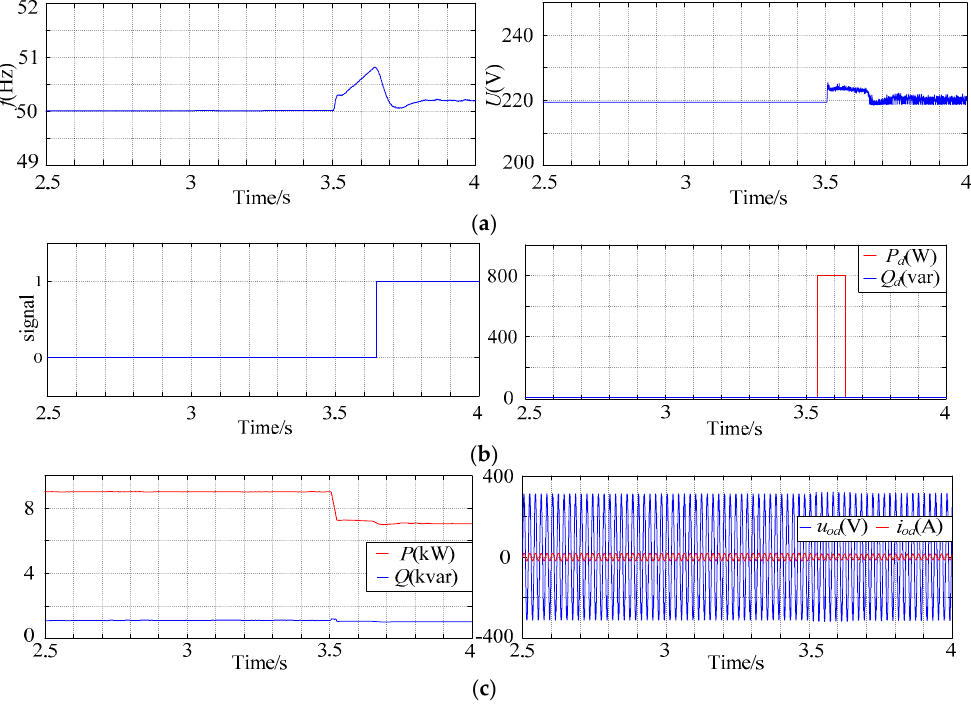
Figure 12. The process of islanding detection when active power unbalanced: ( a ) The output voltage frequency and ampitude of the inverter; ( b ) The signal of islanding detection and the power disturbance; ( c ) The output power and the A phase voltage and current of inverter.